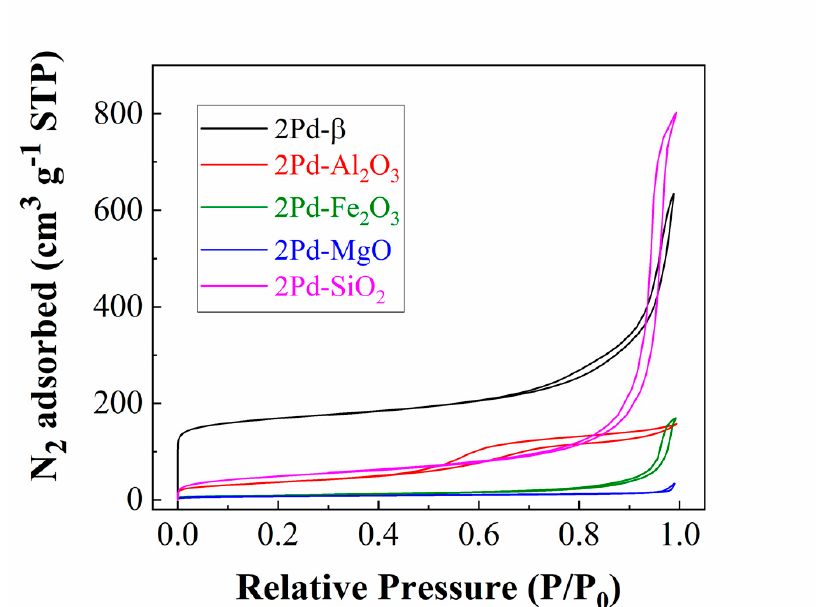
Figure 3. N 2 adsorption–desorption isotherm at − 196 °C of Pd-based catalysts (Pd content: 2 wt.%). Table 1. Textural properties of Pd-based catalysts (Pd content: 2 wt.%).